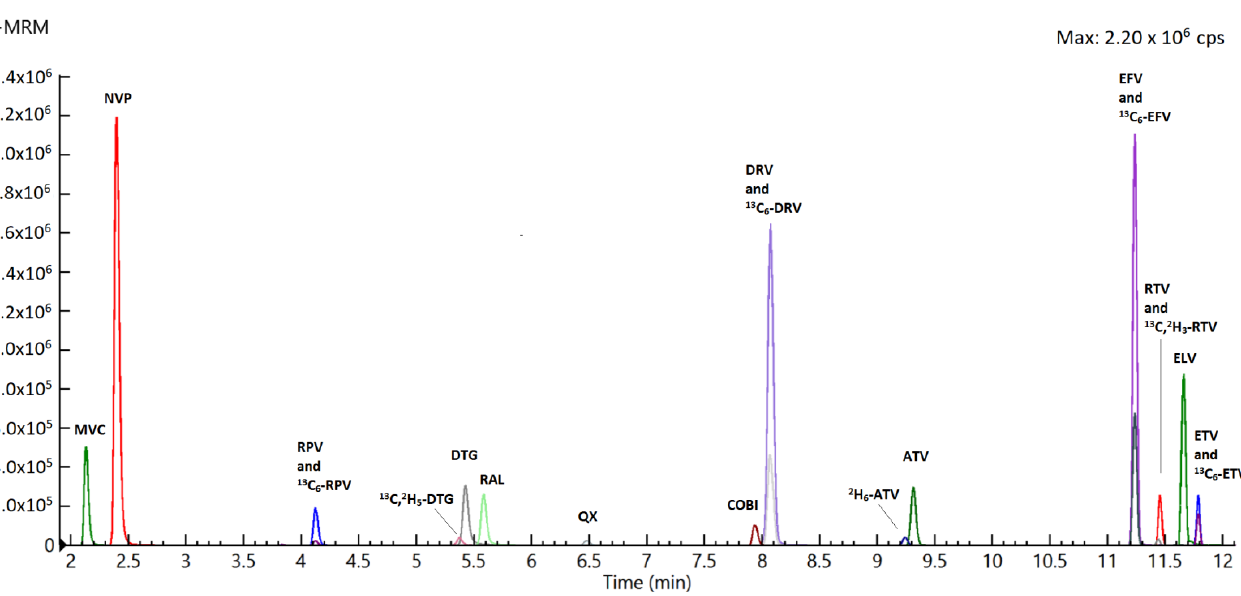
Figure 1. Representative chromatogram of a chemical mix at concentration of 2 μg/mL for each drug.